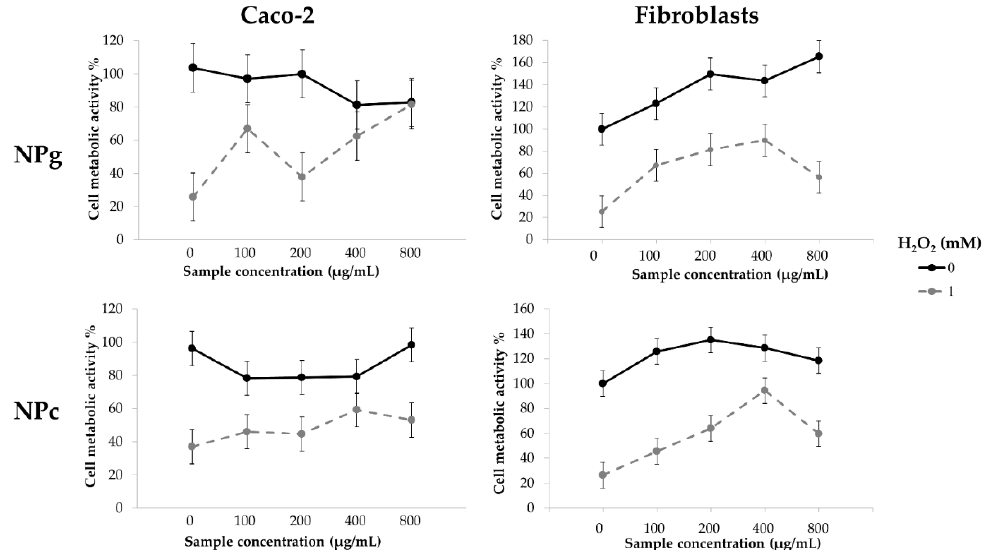
Figure 7. Cytoprotective properties of NPc and NPg on Caco ‐ 2 and human fibroblasts treated (grey dashed line) or not treated (continuous black line) with H 2 O 2 1 mM for 24 h. Multifactor ANOVA, mean values ± least significant difference (LSD), n = 3. The overlap of two LSD intervals graphically indicates the absence of significant differences ( p > 0.05).